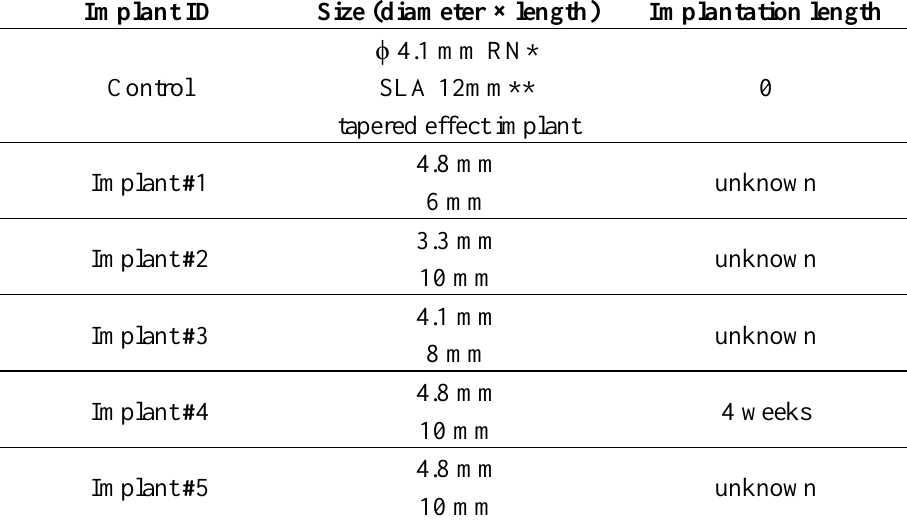
Table 1. Implant